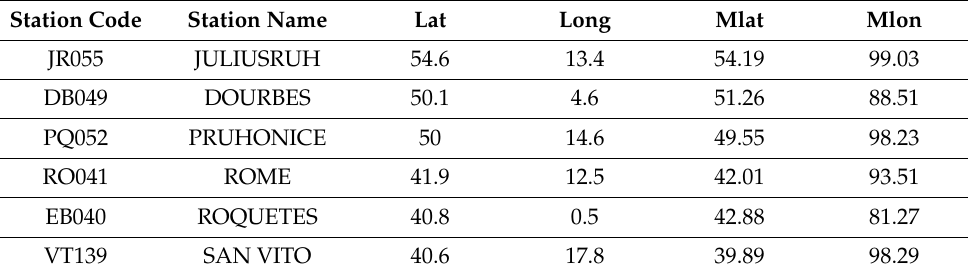
Table 1. Selected ionospheric stations, part of digital ionogram